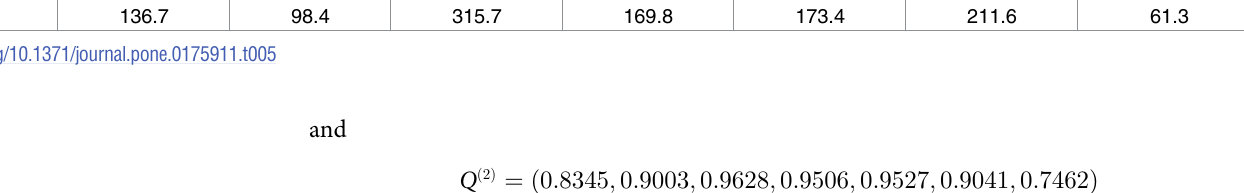
for M = 7. The strongest dependence on the common component, as measured by the smallest rated by C . Since these are the credit classes with the lowest creditworthiness, our results are consistent with the two stylized facts stating that riskier credit classes are affected stronger than more secure ones by macroeconomic conditions and that credit rating migrations in risk- ier credit classes are stronger dependent. See, for example, [16]. Recall that in our case, q both the impact of macroeconomic factors on conditional migrations probabilities and the strength of dependence among migrations. For scheme 1, Table 5 presents the percentage of variation of downgrading probabilities in the case of M = 7. The quoted values evidence that the downgrading probabilities are affected much stronger by adverse macroeconomic condi- tions than by favorable ones. In particular, the percentage corresponding to adverse macroeco- nomic conditions exceeds more than 20 times its counterpart for favorable macroeconomic conditions, if the debtors rated by B are considered. The value 61.3% estimated for the debtors rated at C is consistent with 54.998% obtained by the MMC method for the debtors rated at CCC . ([5], p. 13) In this paper a S&P’s dataset covering the period 1981–2006 is used. Recall that our C rating combines C , CC and CCC of the S&P’s classification. The amplitude of devia- tion of the conditional default probabilities from their historical counterparts is illustrated by Table 6. It contains the conditional default probabilities corresponding to the percentages quoted in Table 5 as well as the unconditional default probabilities.